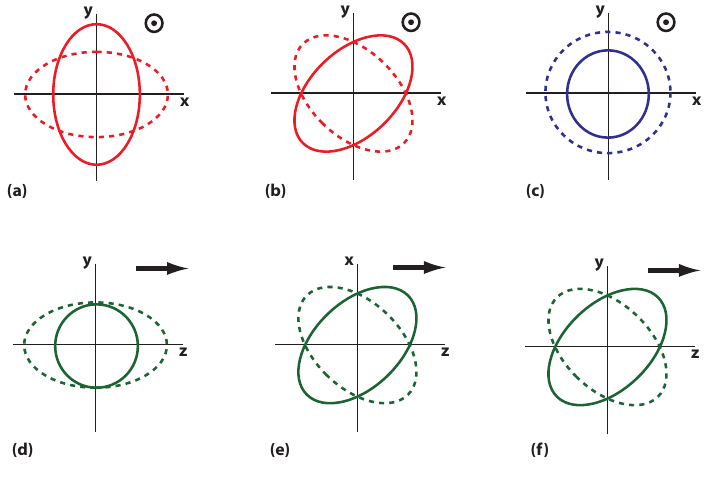
Figure 4: Effect of the six possible GW polarization modes on a ring of test particles. The GW propagates in the z -direction for the upper three transverse modes, and in the x -direction for the lower three longitu- dinal modes. Only modes (a) and (b) are possible in GR. Image reproduced by permission from